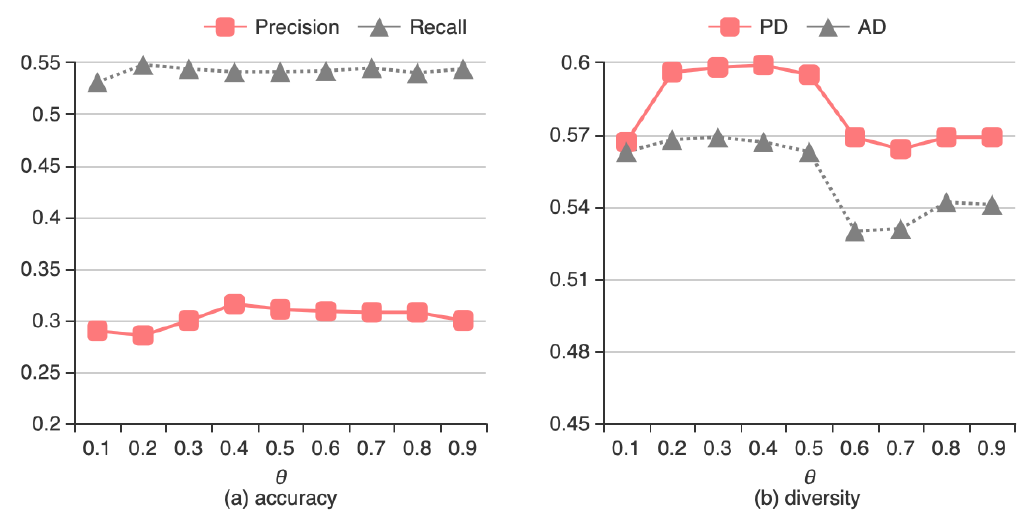
Figure 2. Effect of trust threshold θ on ( a ) accuracy and ( b ) diversity of Diversity Balancing for Two-Stage collaborative filtering (DBTS).